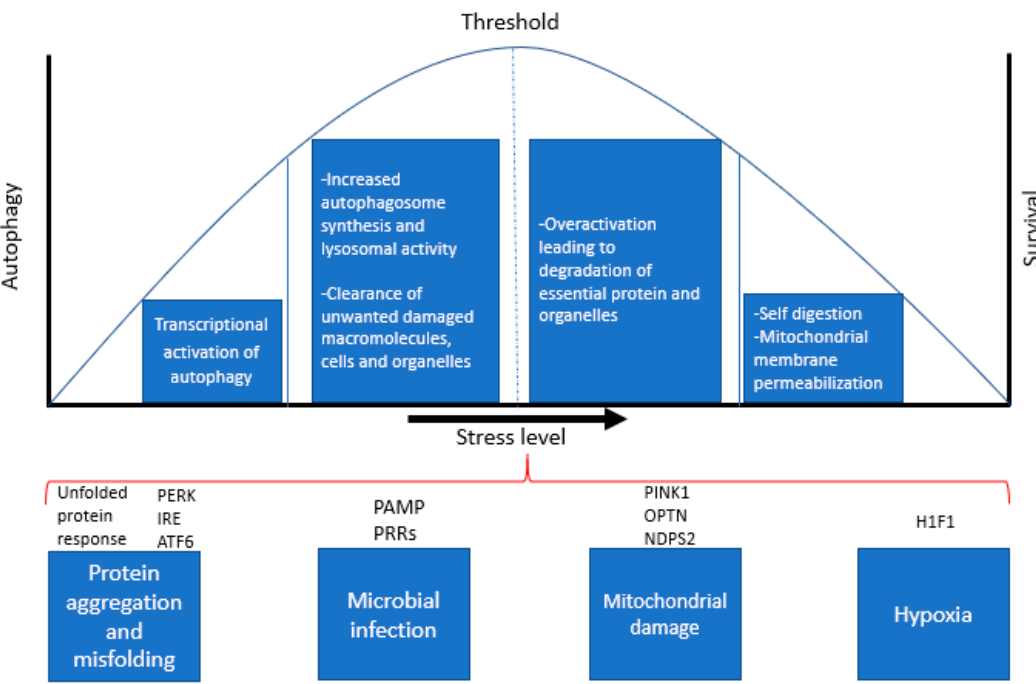
Figure 2. Cellular stress response pathways and regulation of autophagy and apoptosis . The above diagram is a representation of various stress responses that activate autophagy and indicates the levels of stress that determines the cell’s ability to survive or undergo apoptosis.